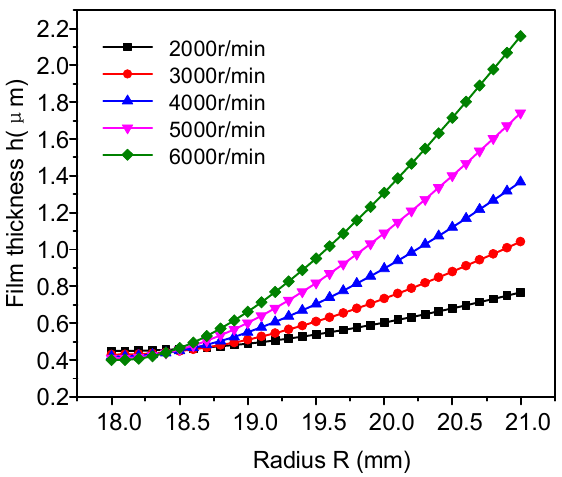
Figure 6. Variation in film thickness in the radius direction at different rotation speeds.